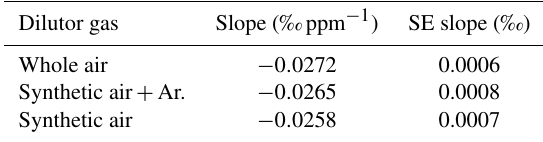
Table 4. CMFD for samples of the same CO 2 diluted back with different dilutors. Per dilutor the slopes, resulting from the linear fits of measured r 636 and 626 isotopologue mole fraction (ppm), and the standard errors of the slopes are